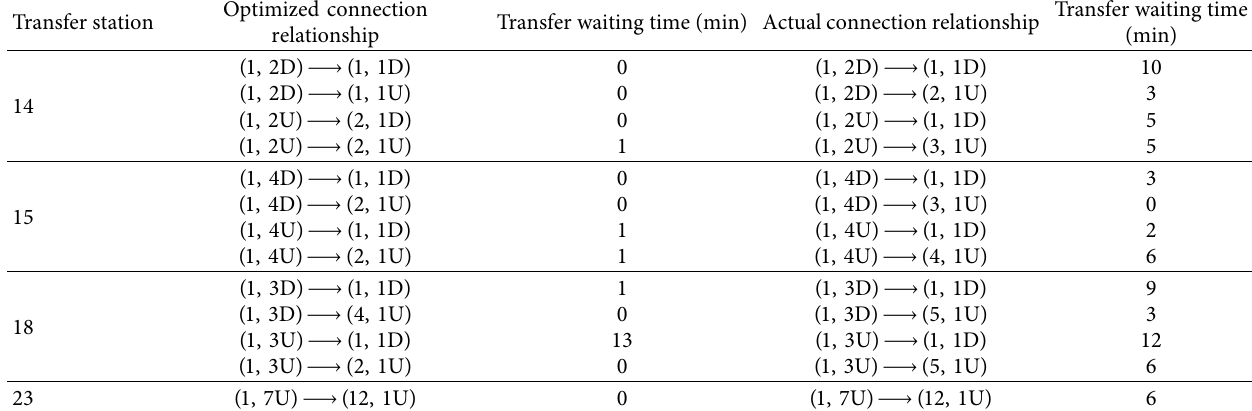
Table 7: Connection relationships for the connecting lines 1U and 1D in solution (5236686, 99). Transfer